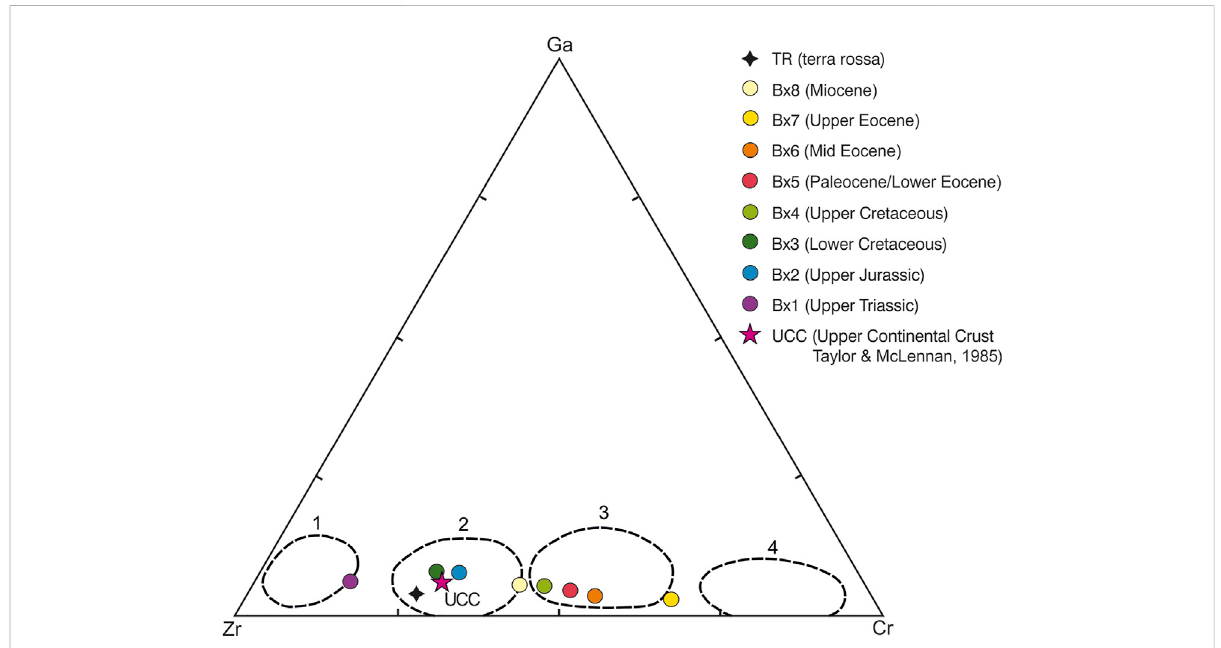
FIGURE 7 Ternary diagram for Zr,Crand Gaconcentrationsinthesamplesoftheeight investigatedgroupsof bauxites inCroatia (BX1-BX8), includingthe soilgroup(TR),representedbytheirmedian(compositional)values;thenumberedcirclesrepresenttheareaofin fl uenceoffelsic(1),intermediate(2), ma fi c (3) and ultrama fi c (4) rocks indicated as probable parent material in genesis of the Mediterranean karst bauxites (after Özlü, 1983); UCC = average Zr-Cr-Ga content in the upper continental crust (modi fi ed after Taylor & McLennan,